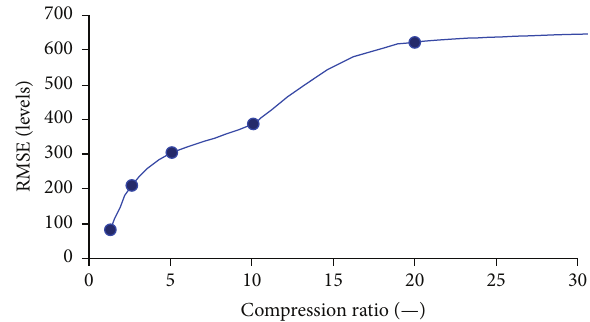
Figure 9: RMSE measurements of light image M7-300ff.dat (wide field camera) versus compression ratio.